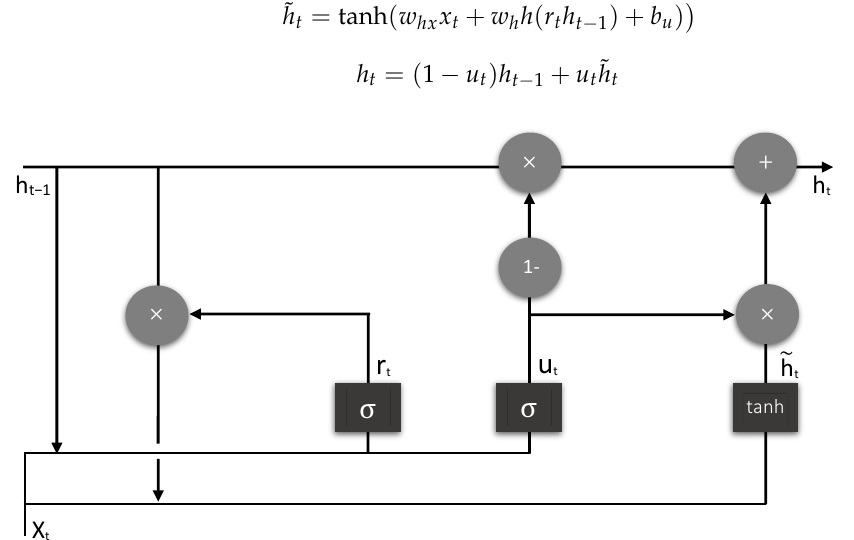
Figure 4. Basic architecture of GRU.